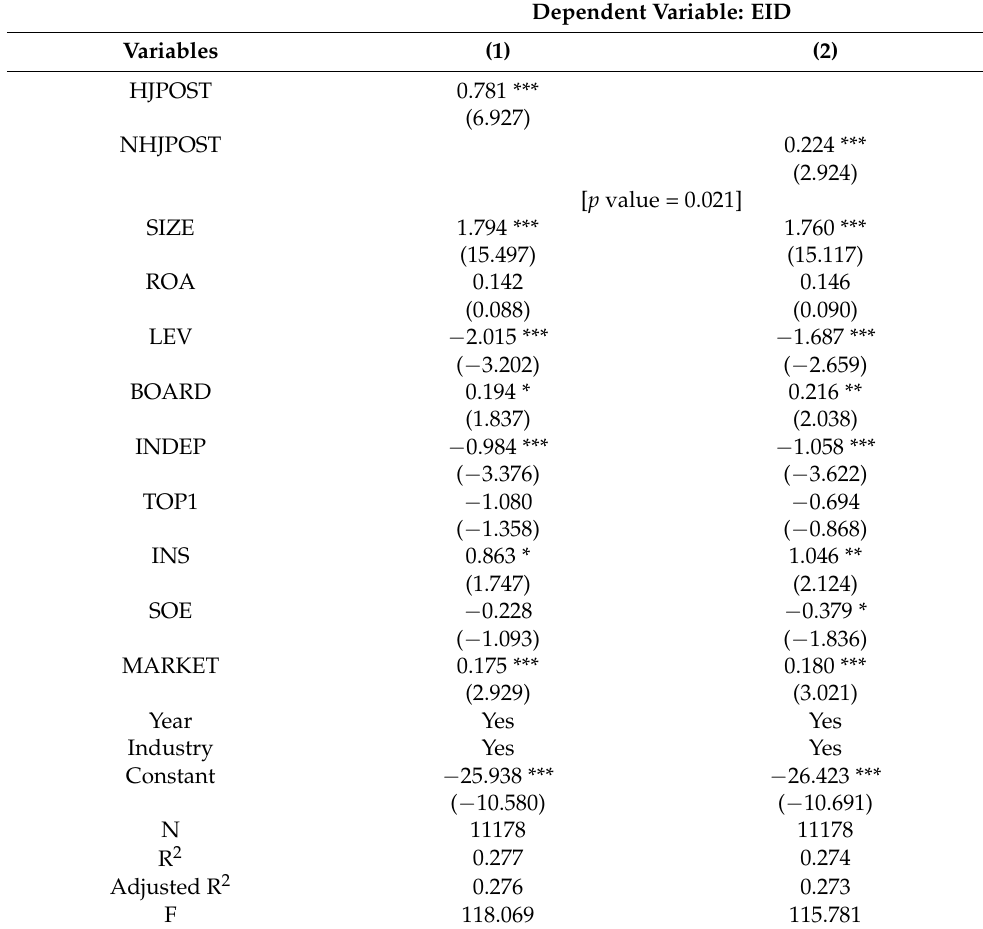
Table 10. Considering the topic of social media